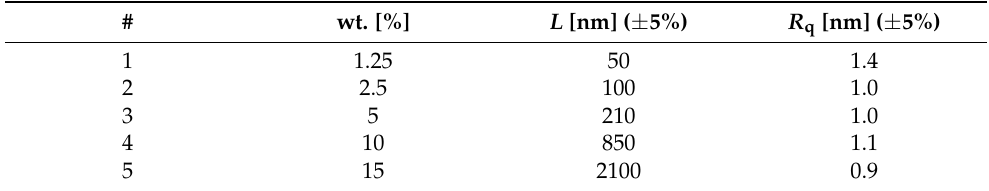
Table 1. Results of the evaluation of the thickness L and roughness R q of polymer films obtained by spin-coating from co-PAEK solutions of various concentrations using AFM.